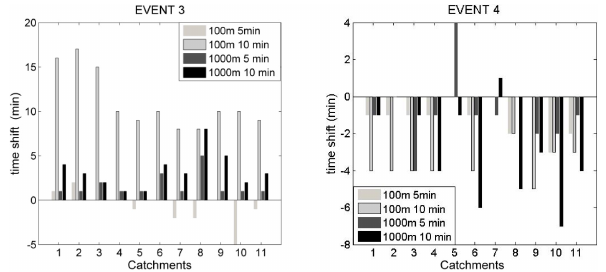
Figure 15. Differences in time to maximum water depth at the out- lets of the 10 subcatchments and of the whole catchment (no. 11) for Events 3 and 4. Simulations at the highest spatial and temporal res- olutions (100m/1000m 1min respectively) are taken as